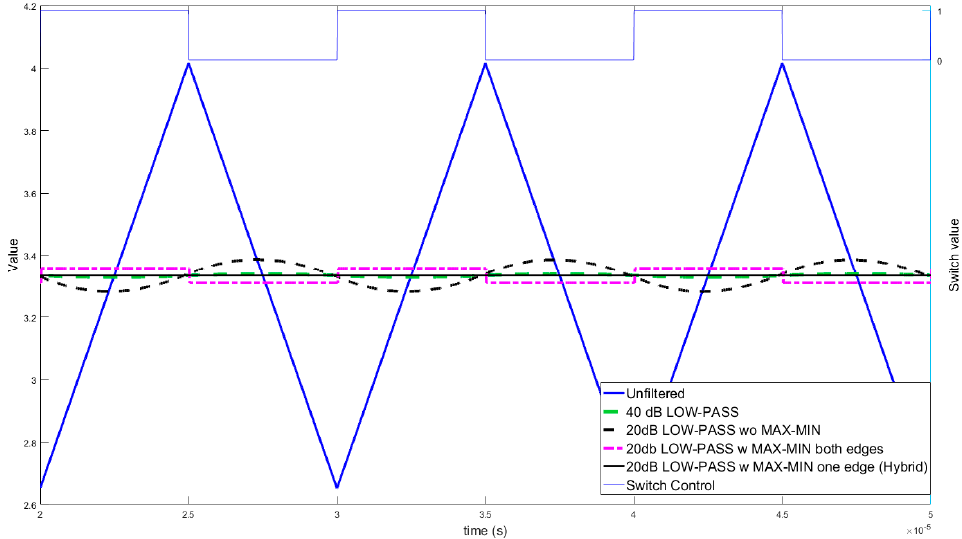
Figure 5. Comparison of the low pass and hybrid filter.